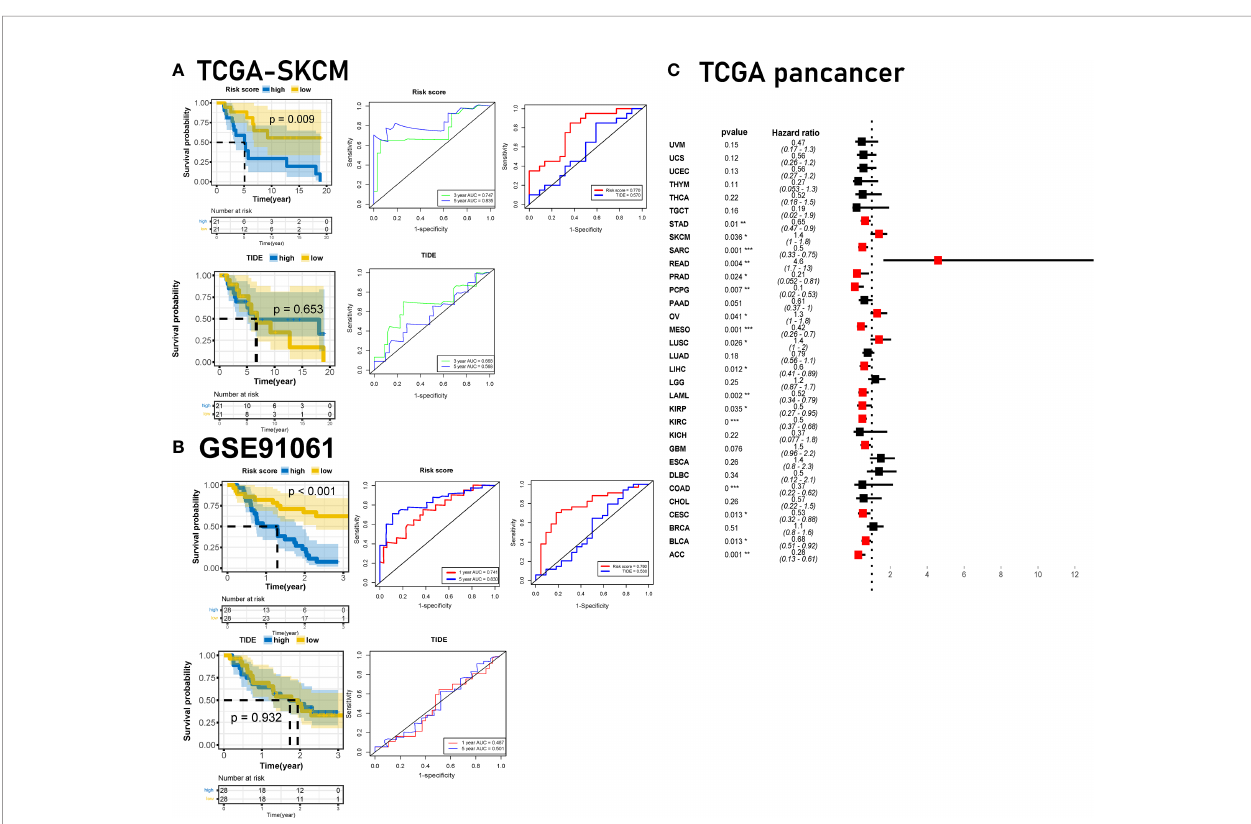
FIGURE 6 | Developing the plac1-related gene risk score and validating it in immune checkpoint blocker cohorts. (A, B) Validation of the prognostic value of the risk score in The Cancer Genome Atlas-skin cutaneous melanoma (A) and GSE91061 (B) datasets compared with TIDE algorithms. (C) Univariate Cox regression analysis of pancancer for plac1. * p < 0.05, ** p < 0.01, *** p <